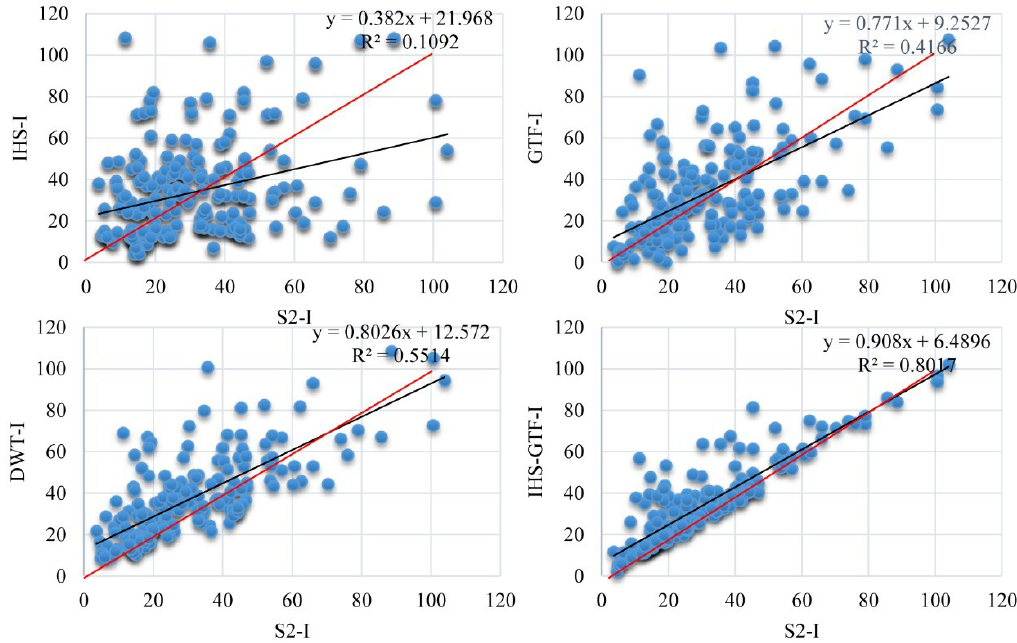
Figure 5. The difference between the I component of the fused images and the I component of Sentinel-2A for Site 1. The black and red lines represent the fitted and 1:1 lines, respectively.